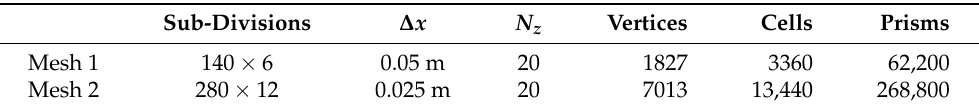
Figure 5. Mesh example applied in the horizontal and vertical direction of the computational domain. The bottom figures corresponds to the 2D view of the selected x - y and x - z regions of the entire domain. Table 2. Details about the meshes used in numerical